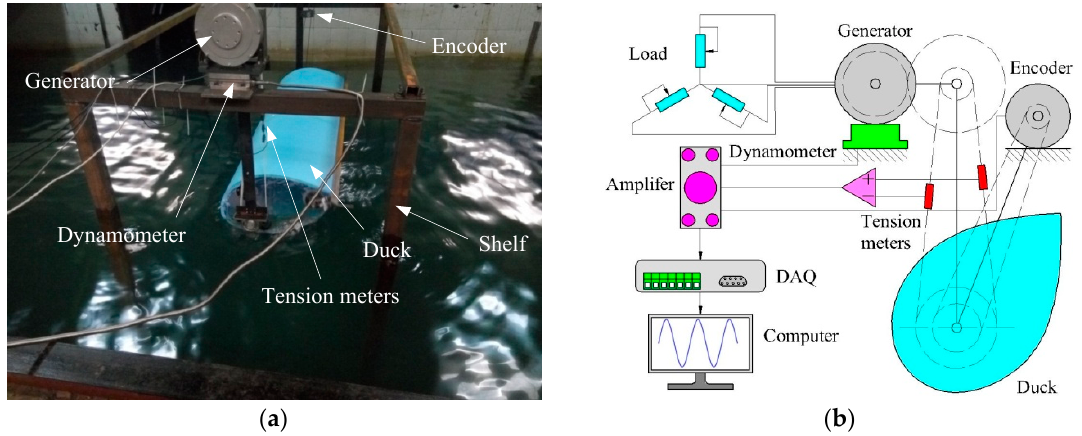
Figure 5. Configuration of the experimental setup: ( a ) physical model; ( b ) simplified schematic diagram.